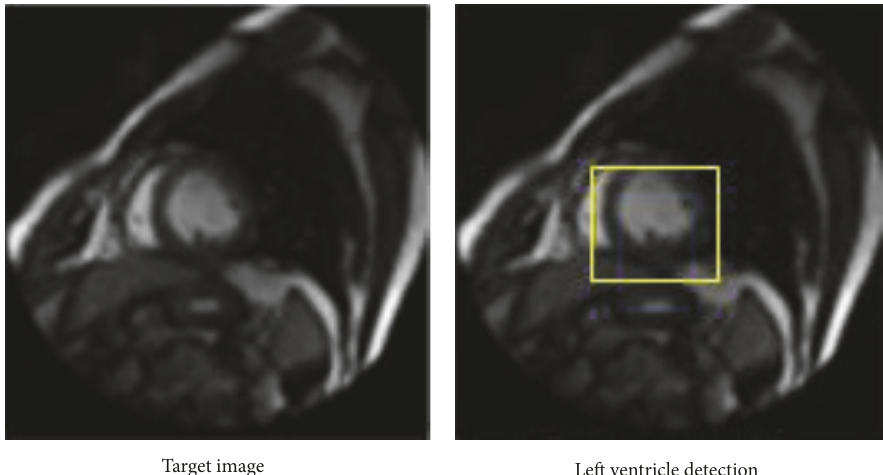
Figure 7: Detection outcome using the developed system (gradient echo sequence, short axis image).